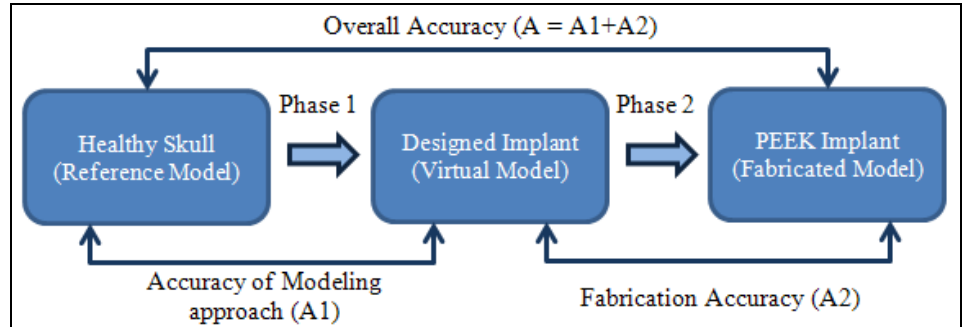
Figure 10. Procedure to estimate the fitting accuracy of the implant.